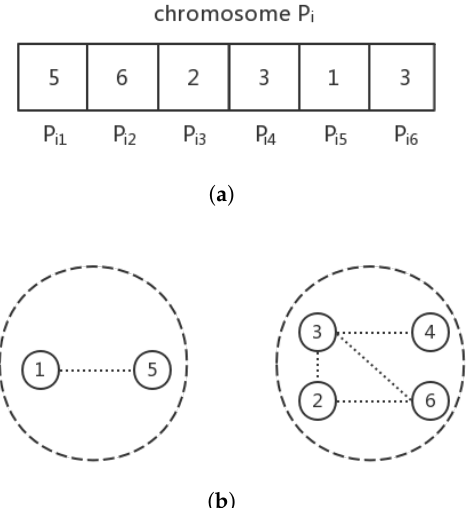
Figure 1. ( a ) A simple example of an adjacency-based chromosome; ( b ) the corresponding community structure decoded from this